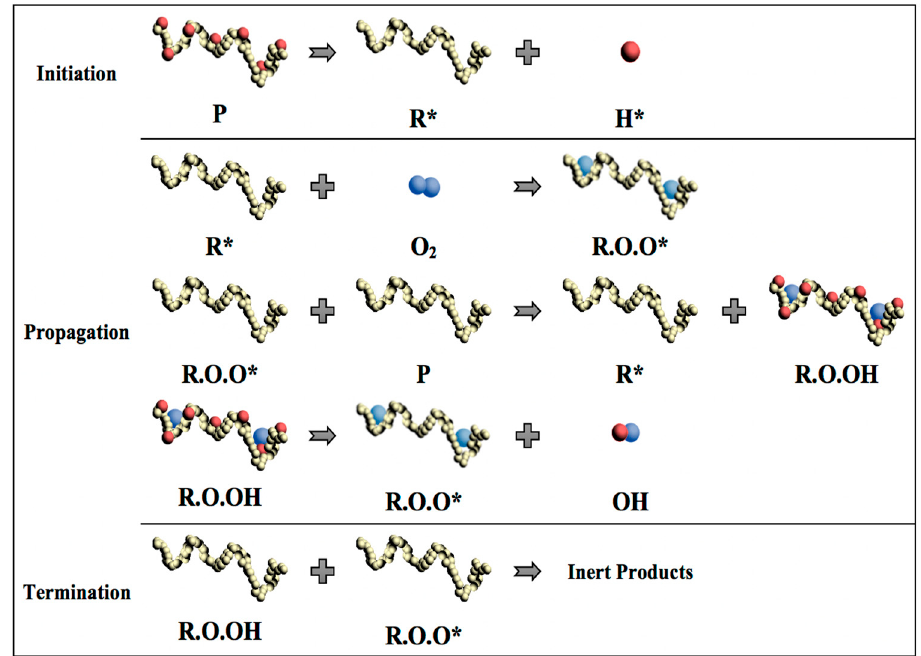
Figure 5. Schematic diagram of polymer chain thermal degradation and formation of free radicals. (P: polymer chain; R*: Free radical; H*: Hydrogen ion; O 2 : Oxygen molecule; R.O.O*: proxy radical; R.O.OH: Hydroproxide; RO* and *OH: Free radical).